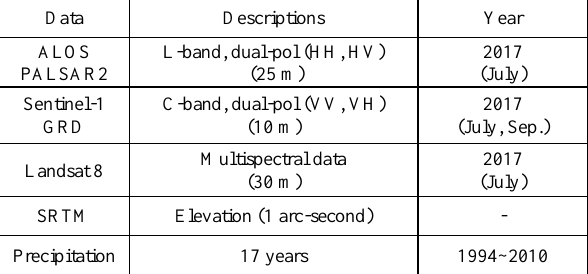
Table 1 . Remote sensing